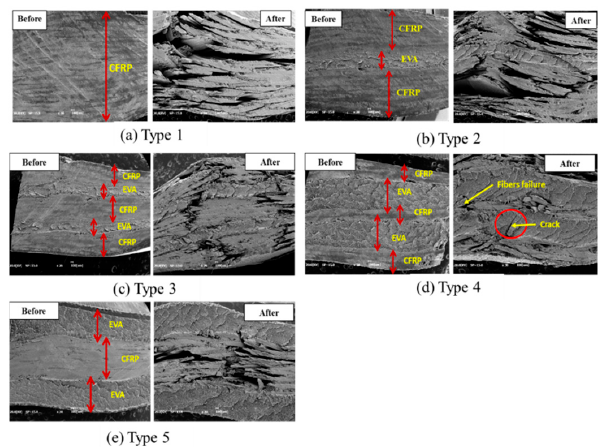
Figure 12. SEM images of each type before and after testing, ( a ) Type 1 (24 CFRP), ( b ) Type 2 (20CFRP:2EVA), ( c ) Type 3 (16CFRP:4EVA), ( d ) Type 4 (8CFRP:8EVA, inside), ( e ) Type 5 (8CFRP:8EVA, outside).